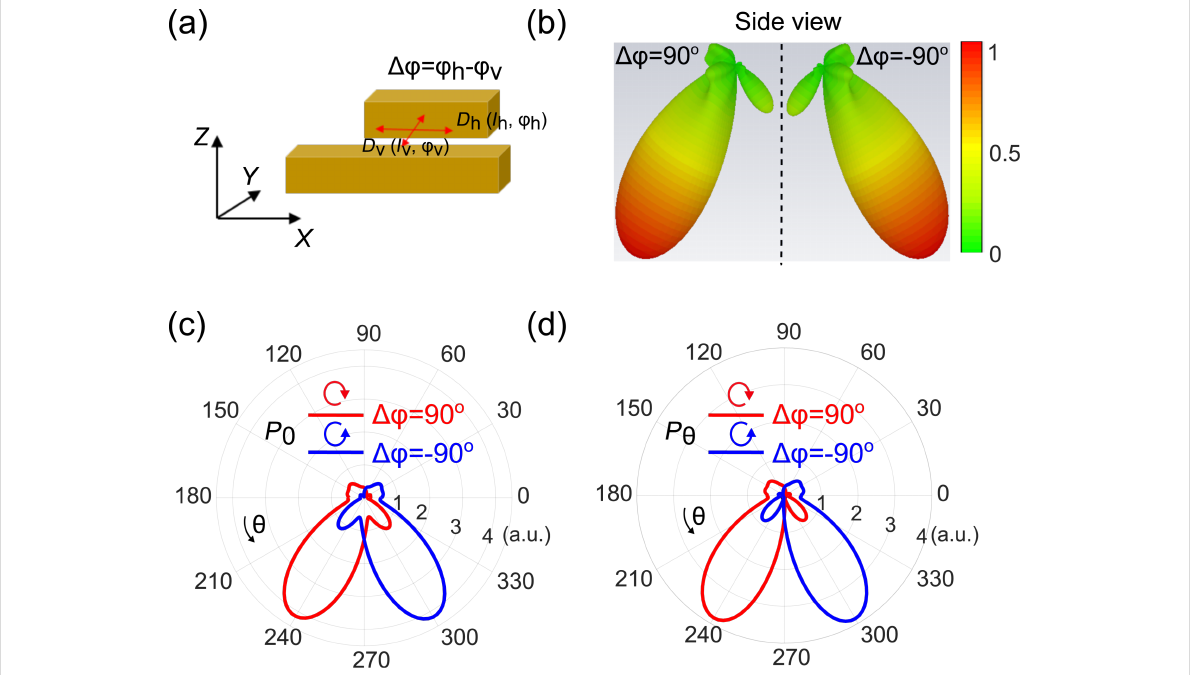
Figure 3: Radiation properties of a double-bar plasmonic antenna. (a) Schematic view of the double-bar antenna. Δφ represents the phase differ- ence between the X - and Y -oriented point-dipole emitters. Δφ = ±90°is used to mimic right or left chiral emitters, respectively. (b) Side view of far-field pattern when Δφ = ±90°. (c, d) Polar plots of the total radiated power ( P 0 ) and the azimuthal component ( P θ ) in the far field, respectively. We show both cases of Δφ =